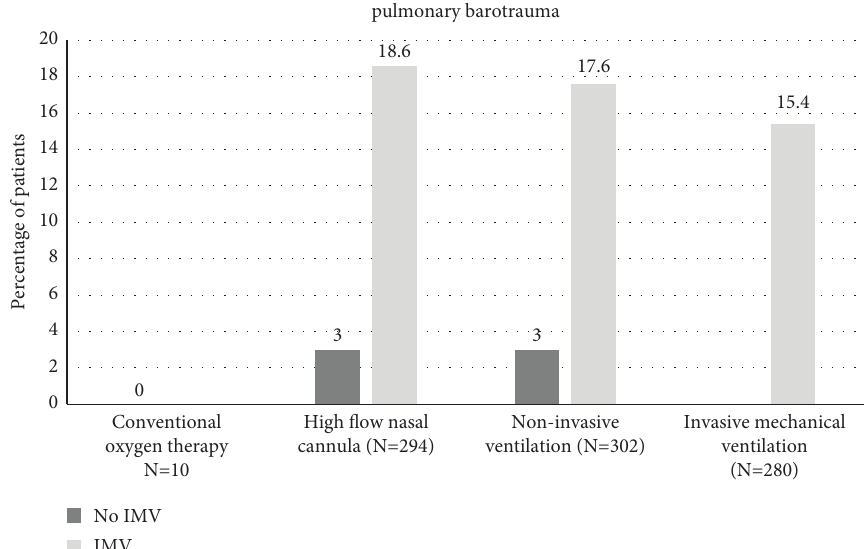
Figure 1: Rate of barotrauma according to the oxygen support modality. Conventional oxygen therapy alone was provided to 10 patients. High-fow nasal oxygen was provided to 294 patients (alternating with non-invasive ventilation in 208 patients); barotrauma occurred in 29 patients (5/165 who did not receive invasive mechanical ventilation (IMV) and 24/129 who received IMV). Noninvasive ventilation was provided to 302 patients; barotrauma occurred in 30 patients (4/132 who did not receive IMV and 30/170 who received IMV). IMV